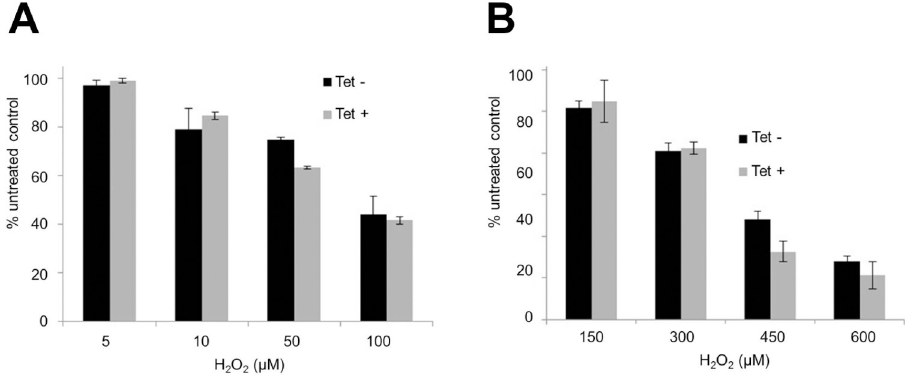
Fig 8. Tb SELENOT knockdown does not affect procyclic and bloodstream T . brucei sensitivity to H 2 O 2 . Tetracycline non-induced (black) and induced (grey) T . brucei cells were treated with various concentrations of DTT and tunicamycin. The plots show cell concentration relative to untreated control after a 24h-incubation at 28˚C and 37˚C for procyclic (PCF) and bloodstream (BSF) T . brucei , respectively. Tb SELENOT-RNAi A- PCF and B- BSF T . brucei cells were also treated with various concentrations of H 2 0 2 . Bars show the cell concentration relative to untreated controls after an 18h-incubation at 28˚C and 37˚C for PCF and BSF T . brucei , respectively. The average of 3 independent experiments is shown together with the respective standard